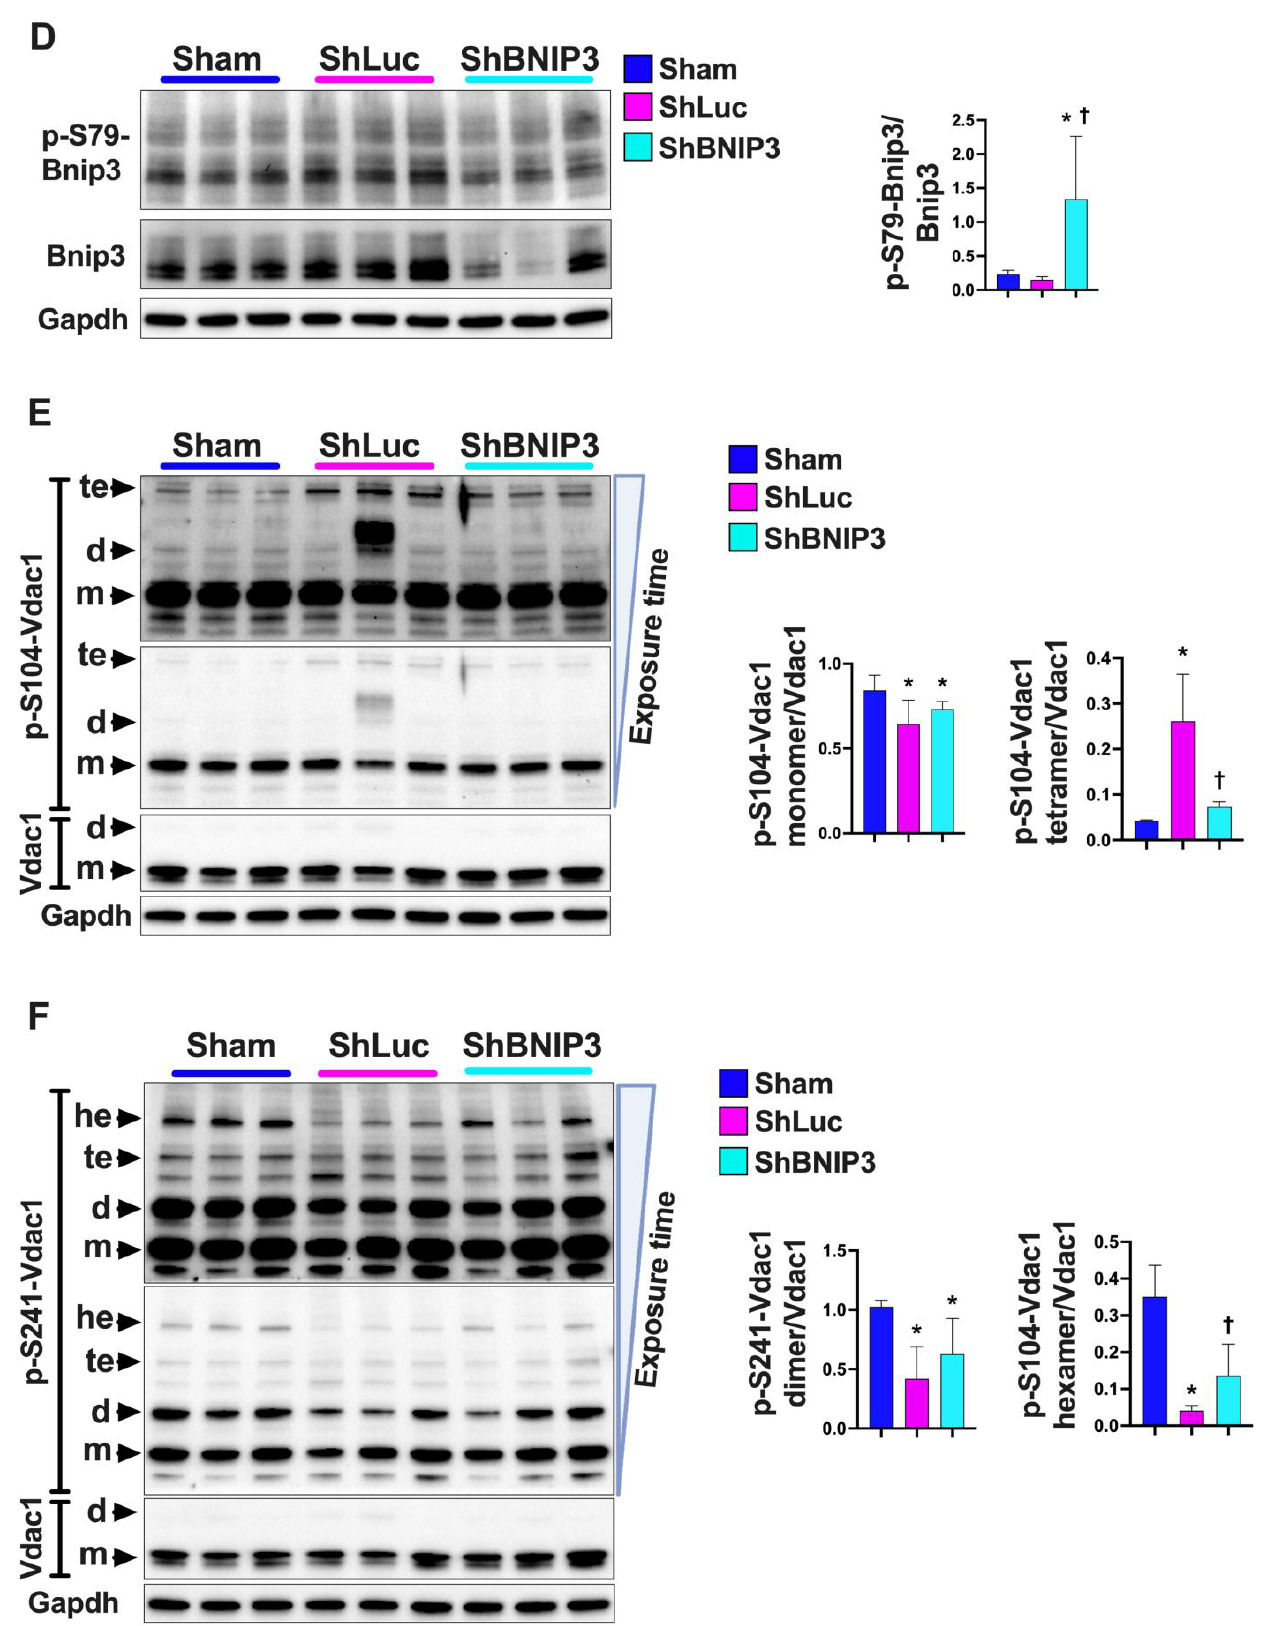
Figure 6. Validation of the LV and RV phosphoproteomic findings. ( A ). Heat maps of the Canonical signaling pathways that were enriched by −Log 10 p -value in the phosphoproteomic datasets. The